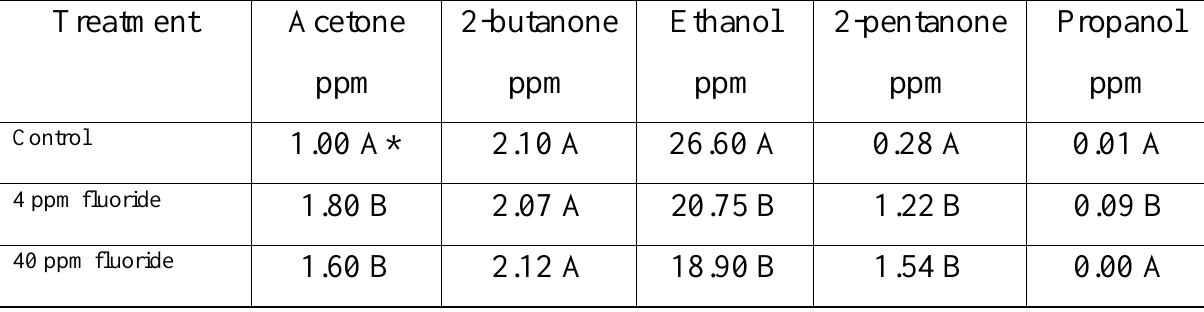
days of ripening